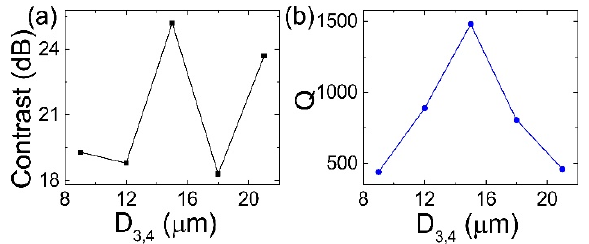
Figure 8. ( a , b ) The corresponding variations of the contrast and quality factor of 4-spheres-loop sensors undet different D 3,4 .